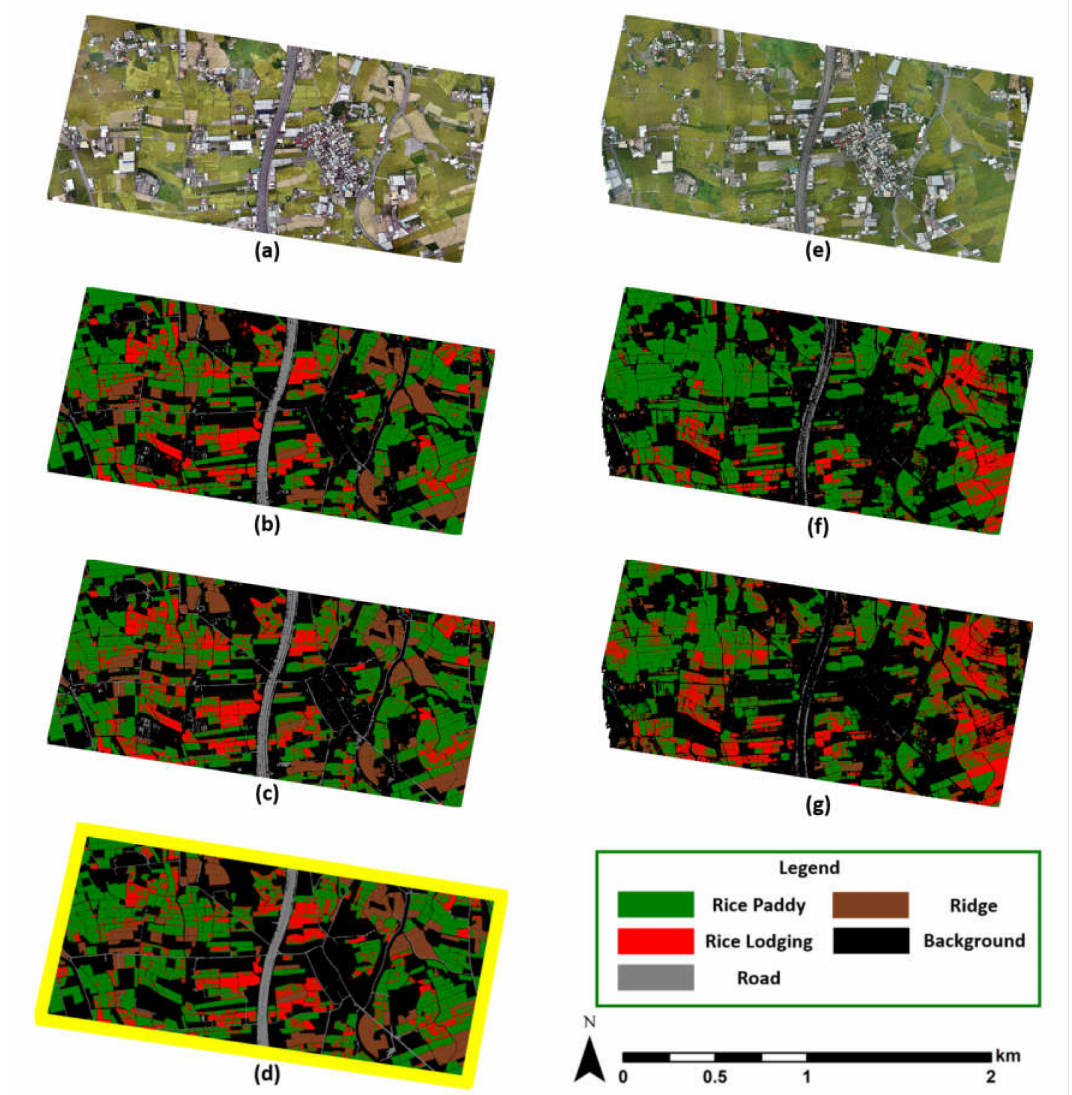
Figure 16. Results of identification on the total 230 ha. area by the best performance models: ( a ) 2017 dataset orthoimage, ( b ) 2017 dataset prediction of FCN-AlexNet using RGB + ExGR information, ( c ) 2017 dataset prediction of SegNet using RGB + ExGR, ( d ) ground truth, ( e ) 2019 dataset orthoimage, ( f ) 2019 dataset prediction of FCN-AlexNet using RGB + ExGR information, (g ) 2019 dataset prediction of SegNet using RGB +